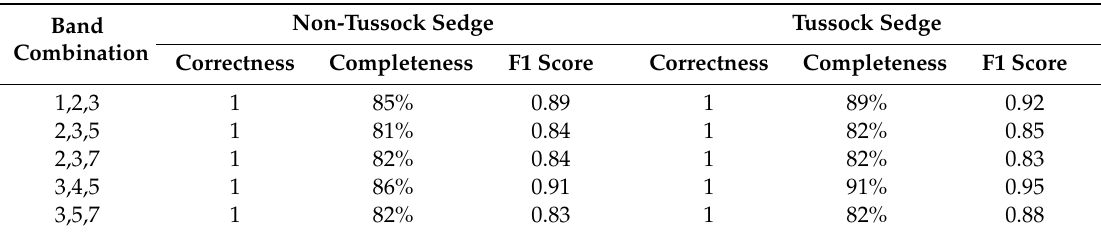
Table 3. Accuracy assessment of detection for candidate image scenes.